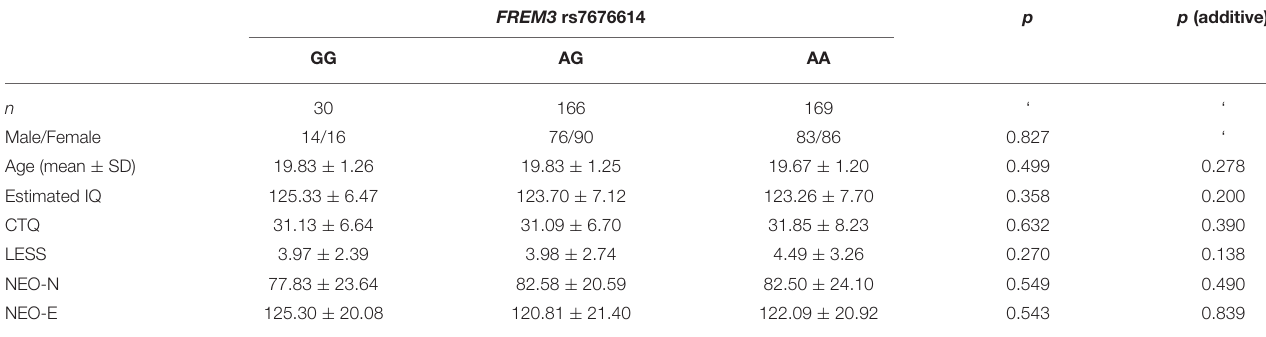
The table includes p-values from both a mean comparison (ANOVA) and an additive (regression)